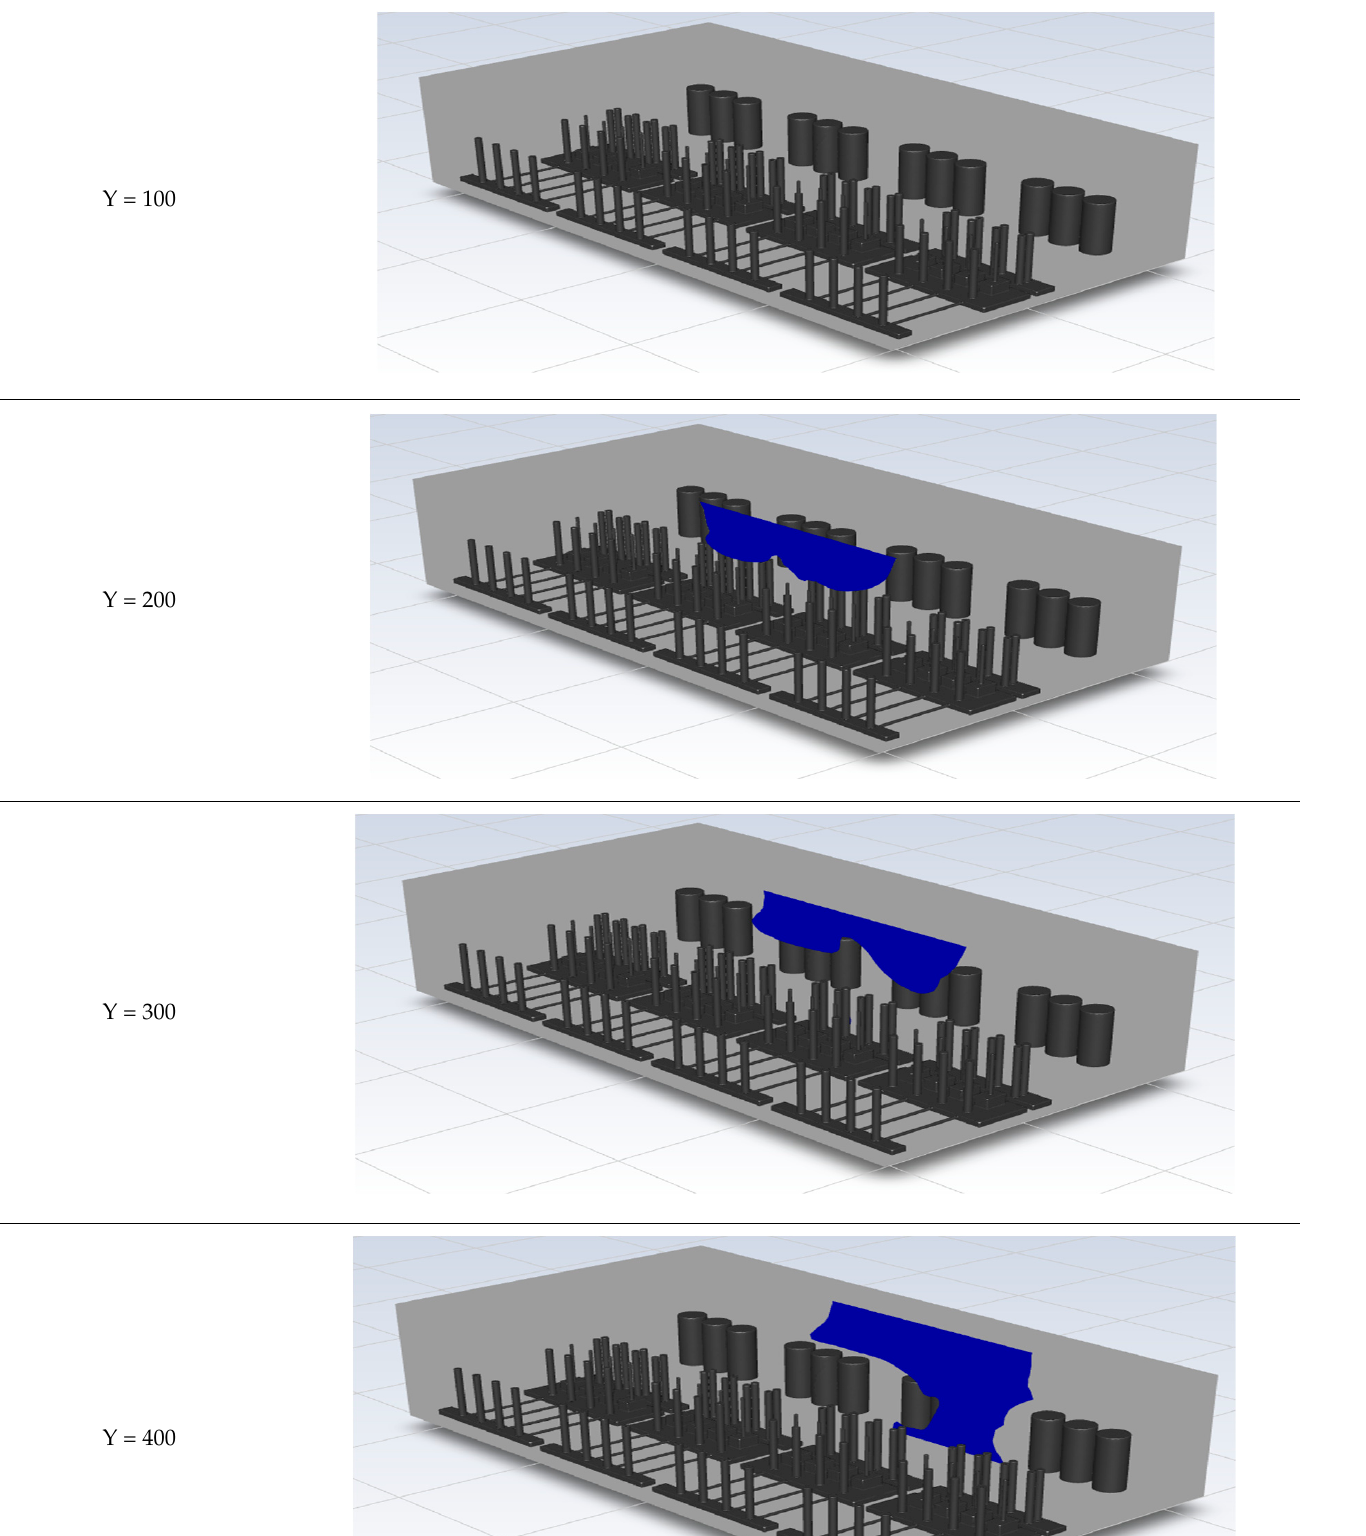
Table 9. Distribution of concentrations exceeding 25% of the LFL on the ZX section.